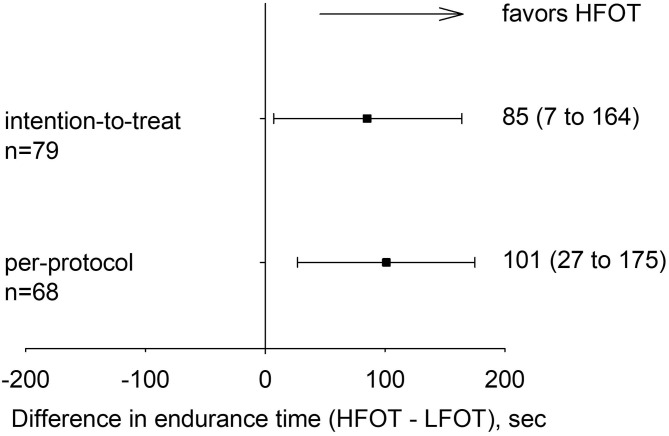
Primary outcome: difference with 95% confidence intervals in cycling endurance time between tests on high-flow oxygen therapy (HFOT) and low-flow oxygen therapy (LFOT) for the intention-to-treat and per-protocol analyses.